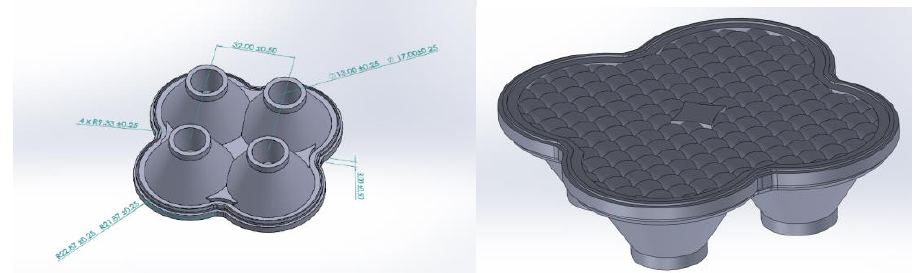
Figure 5. Auto LED lens sample diagram by SolidWorks.